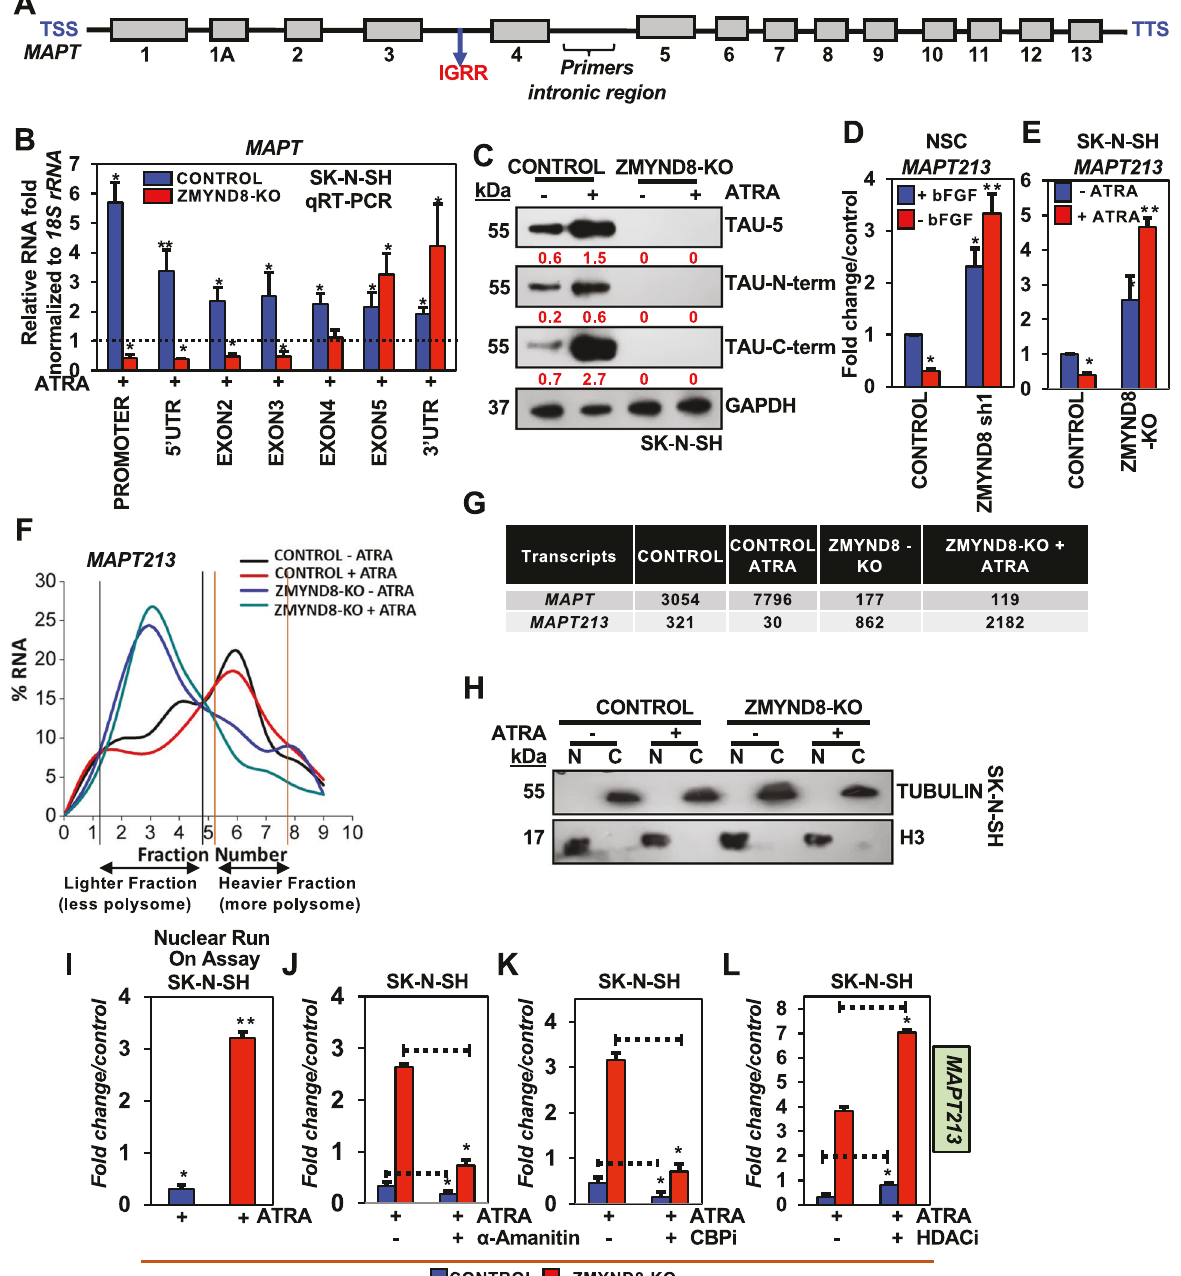
Fig. 7 The absence of ZMYND8 triggers the expression of the non-coding transcript from the intra-gene regulatory region of the MAPT gene. A Schematic representation of MAPT gene representing the TSS (Transcription Start Site), exons (1-13), intra-gene regulatory region, an intronic region from where primers were designed for the noncoding transcript, and TTS (Transcription Termination Site). B qRT-PCR showing expression of MAPT transcripts from the promoter, 5'UTR, Exons 2 – 5, and 3'UTR in ZMYND8 -knockout ( ZMYND8 -KO) or control SK-N-SH cells with or without ATRA treatment. C Immunoblots showing TAU expression with anti-TAU antibody against epitopes speci fi c to N-term, C-term, or TAU5 in ZMYND8 -knockout ( ZMYND8 -KO) or control SK-N-SH cells with or without ATRA treatment. GAPDH served as a loading control. The immunoblots are quanti fi ed and represented as numerical, re fl ecting the band intensity normalized to loading control. D , E qRT-PCR showing expression of MAPT Intra gene transcript (MAPT213) upon ZMYND8 knockdown in bFGF depleted NSC ( D ), or ATRA treated ZMYND8 knockout ( ZMYND8 -KO) SK-N-SH cells ( E ). F Polysome pro fi ling to determine the polysome bound fractions of MAPT Intra gene transcript (MAPT213) in ZMYND8 -knockout ( ZMYND8 -KO) or control SK-N-SH cells with or without ATRA treatment. G Copy number /number of molecules of full-length MAPT and MAPT Intra gene transcript (MAPT213) determined from ZMYND8 -knockout ( ZMYND8 -KO) or control SK-N-SH cells with or without ATRA treatment. H Immunoblot showing the ef fi ciency of cell fractionation. Histone H3 and Tubulin are used as nuclear or cytosolic markers, respectively. I Nuclear run-on assay to show MAPT Intra gene transcript transcription ef fi ciency in ZMYND8 -knockout ( ZMYND8 -KO) or control SK- N-SH cells with or without ATRA treatment. J – L qRT-PCR showing expression of MAPT Intra gene transcript under α -Amanitin (10 μ g/ml for 16 h) ( J ), CBP inhibitor (Curcumin 10 μ M for 16 h) ( K ), or HDAC1 inhibitor treatment (TSA 2 μ M for 24 h) ( L ) in ZMYND8 -knockout ( ZMYND8 -KO) or control SK-N-SH cells with or without ATRA treatment. Error bars indicate sem.; n = 3; three independent experiments. A two-tailed t -test was used to calculate P -values. * P < 0.05; ** P < 0.01. Cell Death and Disease (2022)